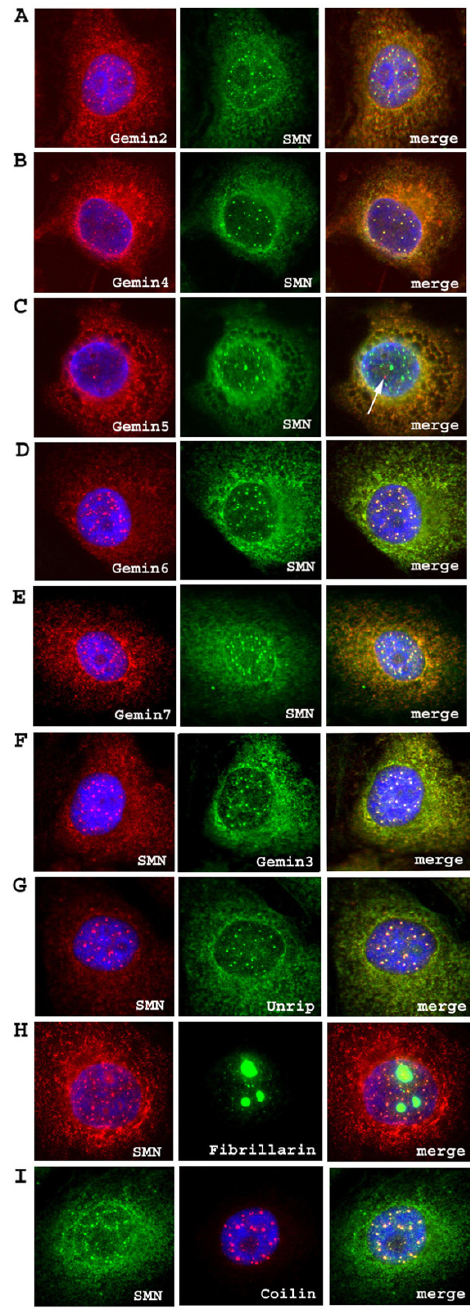
Figure 4 Overexpression of SMN in HeLa cells stimulates formation of gems/CBs containing other gemins, except gemin 5 . Gemin2 (A), gemin 4 (B), gemin6 (D) and 7 (E) co-localise with SMN in HeLa cells stably transfected with human SMN1 in pcDNA3 [49]. Gemin5 (C) does not co-localise with SMN. The same mAbs as in Fig. 2 were used, plus MANSIP1A for gemin2. Double label of SMN mAb MANSMA1 with gemin3 rabbit antiserum (F), unrip rabbit antiserum (G) and fibrillarin human auto-antiserum (H), or SMN antiserum with p80 mAb (I) were performed on the HeLa cell line stably transfected with SMN1. Alexa fluor 546 goat anti-mouse IgG (red) was used to detect mouse mAbs and Alexa fluor 488 goat anti-rabbit IgG (green) was used to detect rabbit antibodies. FITC-conjugated goat anti-human IgG (Chemicon) was used to detect fibrillarin. DAPI (blue) was used to counterstain the